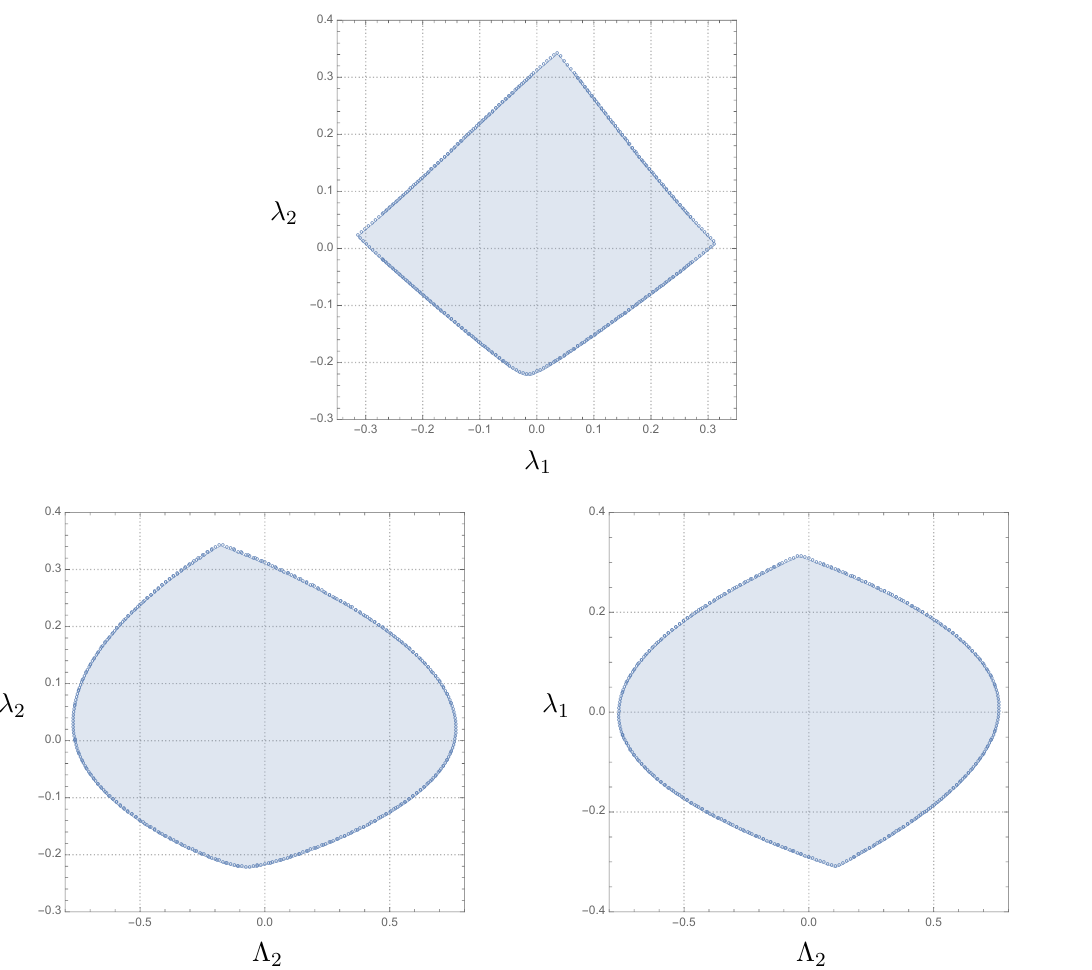
Figure 6 . Three sections of the parameter space showing the region accommodating regular holographic RG flows involving the N = 2 & SU (2) J-fold CFT (bottom-left) and λ = 0 2